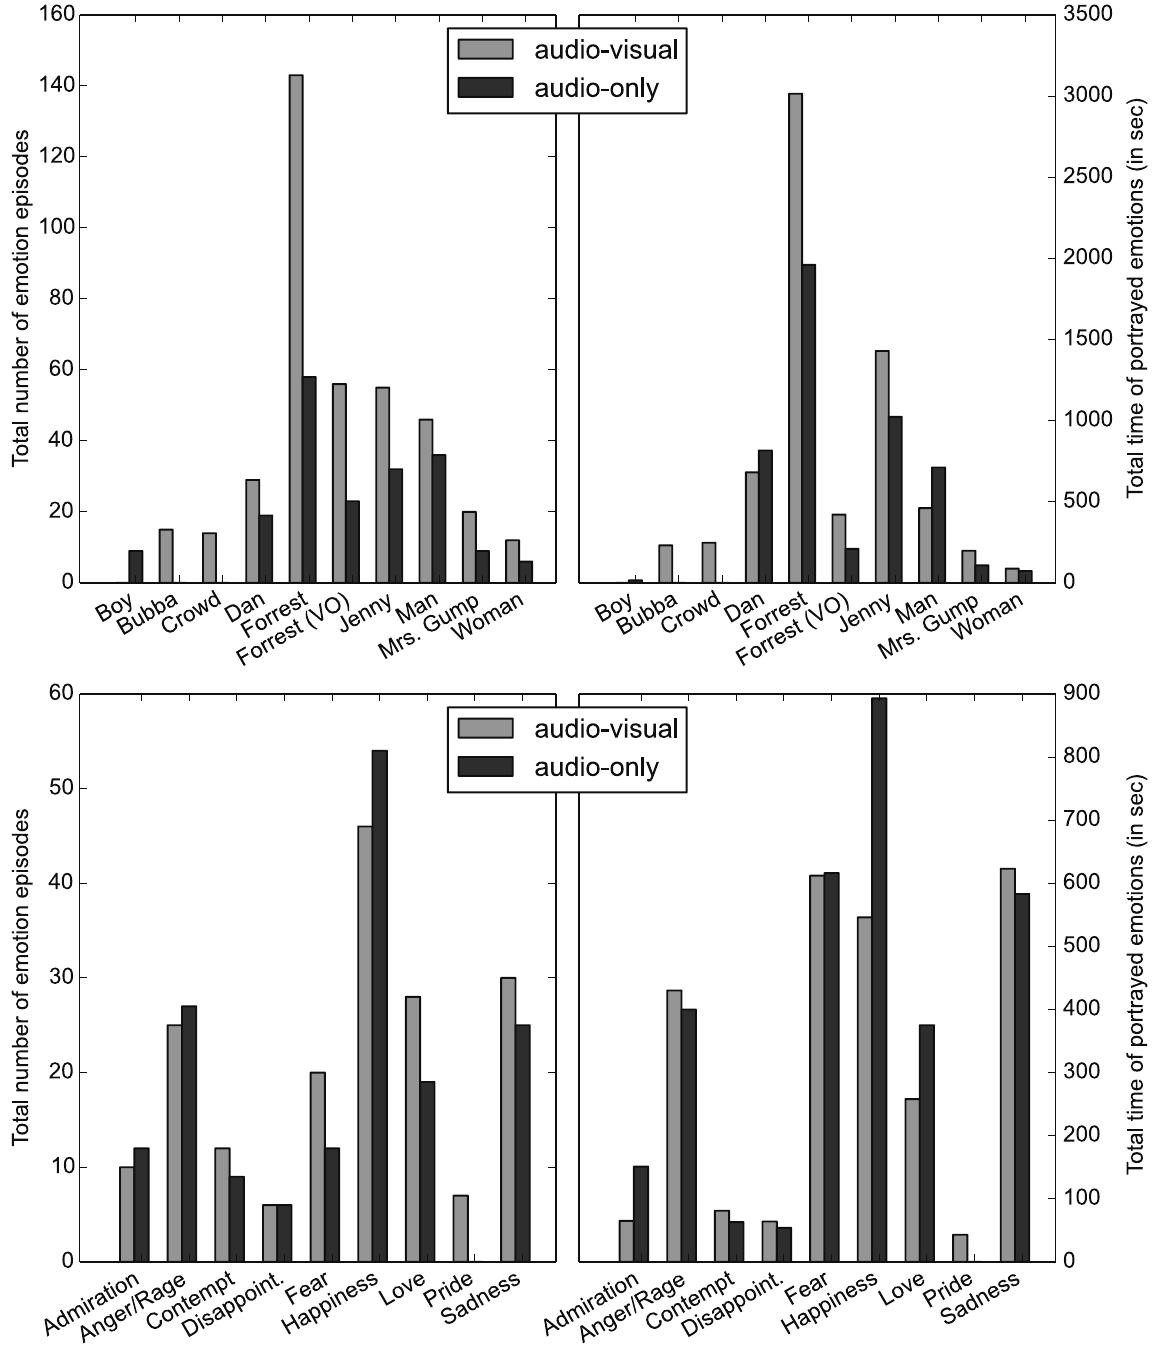
Figure 1. Annotation frequencies by character and emotion. The minimum criterion for counting emotion episodes is a 50% inter-observer agreement. Only categories/characters with a minimum of five such episodes are shown. The left panels show the number of episodes for both movie variants; the right panels show the cumulative duration of emotion display across all considered episodes. The top panels show the annotation frequency by movie character; the bottom panels show the corresponding frequencies for emotion categories.